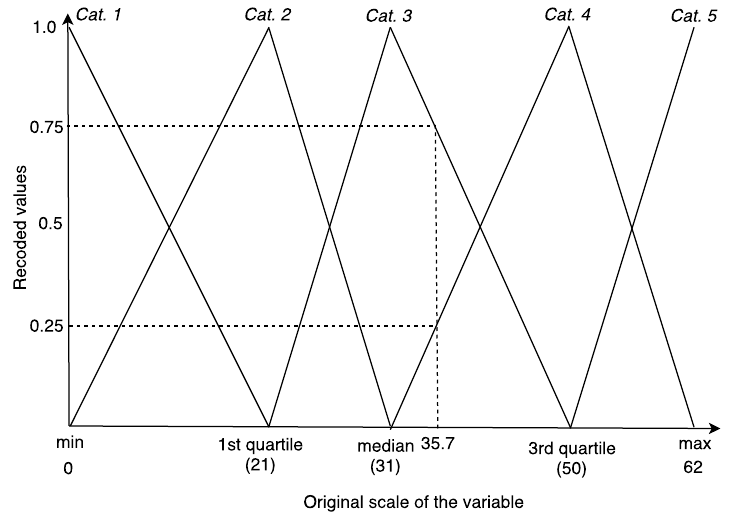
Figure 1: Triangular membership functions to code a continuous variable (hori- zontal axis) into five fuzzy categorical variables. An example is shown of a value on the orginal scale ( 35 . 7 ) being fuzzy coded as [ 0 0 0 . 75 0 . 25 0 ].